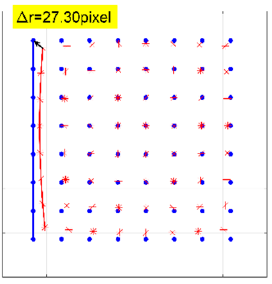
Figure 8. Corners image with the red asterisks representing the corners of the distorted checkerboard image and the blue points representing the corners of the corrected checkerboard image. The curvature radius of the red line is 2.2148 × 10 3 pixels, and that of the blue line is 1.4731 × 10 5 pixels.